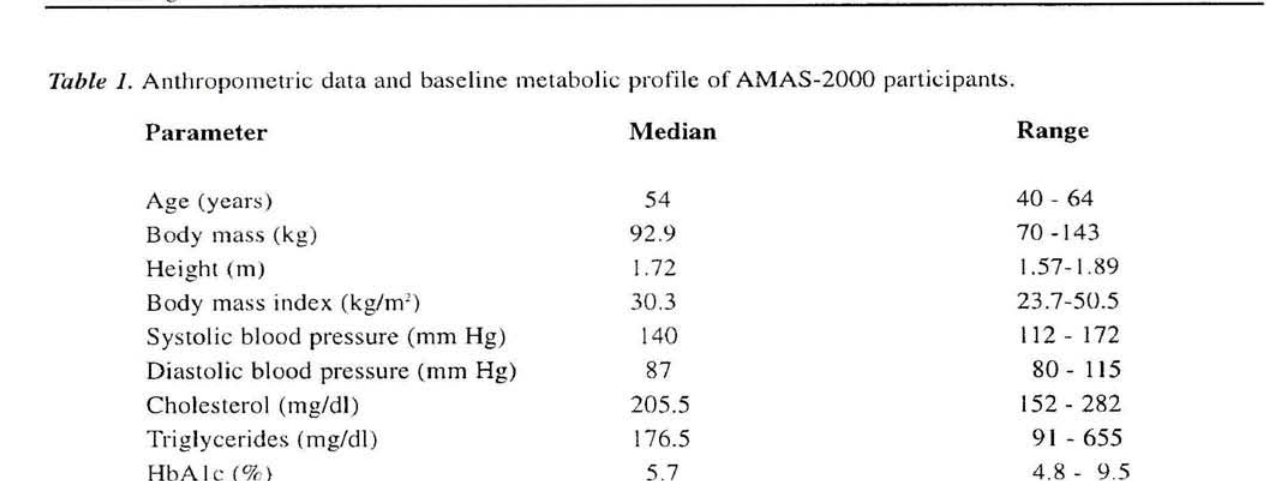
Table 1. Anthropometric data and baseline metabolic profile of AMAS-2000